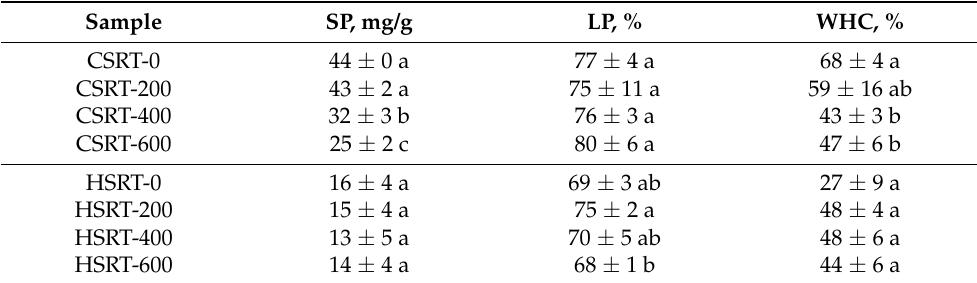
Table 1. Level of proteolysis (LP) (mg/g ± standard deviation), amount of soluble protein per g of muscle sample (SP) (% ± standard deviation), and water-holding capacity (WHC) (% ± standard deviation) of cold smoked rainbow trout (CSRT) and hot smoked rainbow trout (HSRT) samples treated with high pressure processing at 0, 200, 400, and 600 MPa. Within sample types (CSRT or HSRT), samples with same letters do not vary at a statistically significant level (Dunnett’s T3, p < 0.05).